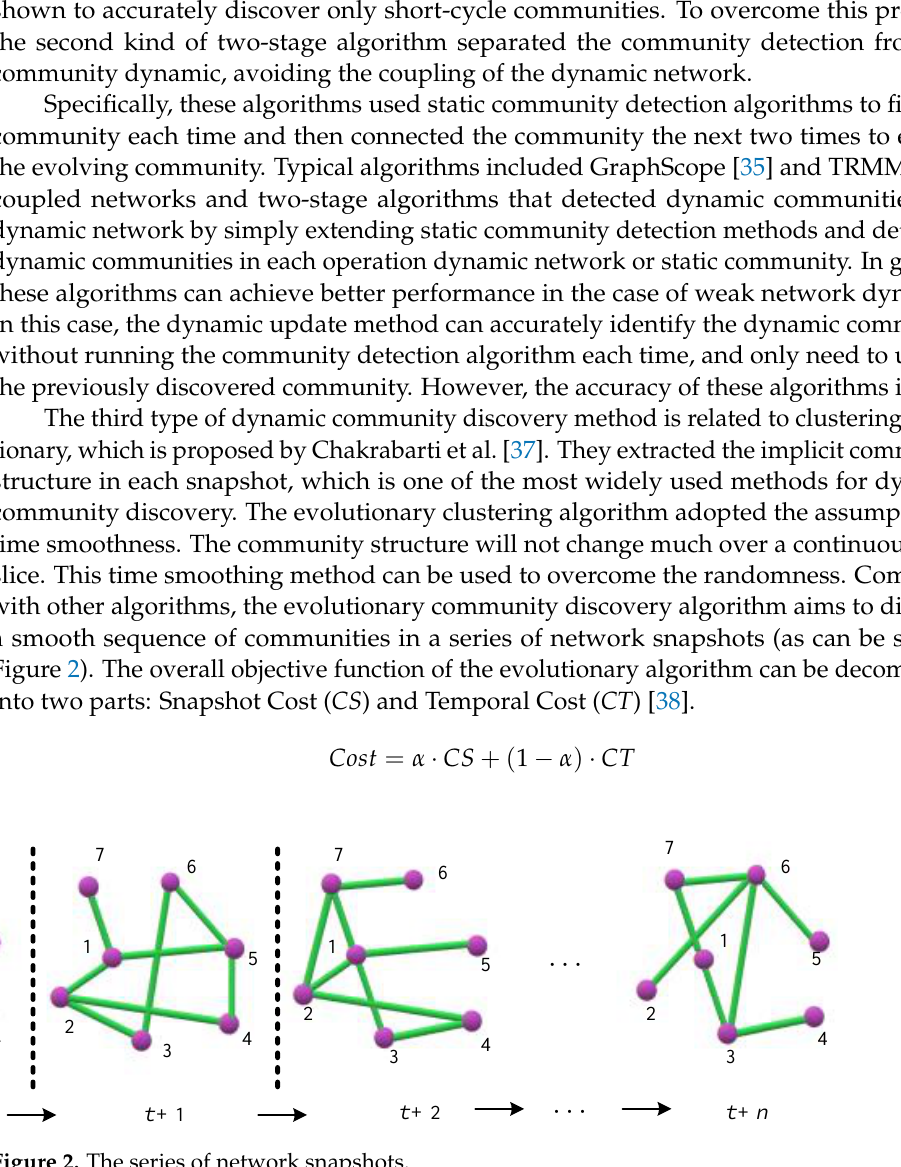
Figure 2. The series of network snapshots.